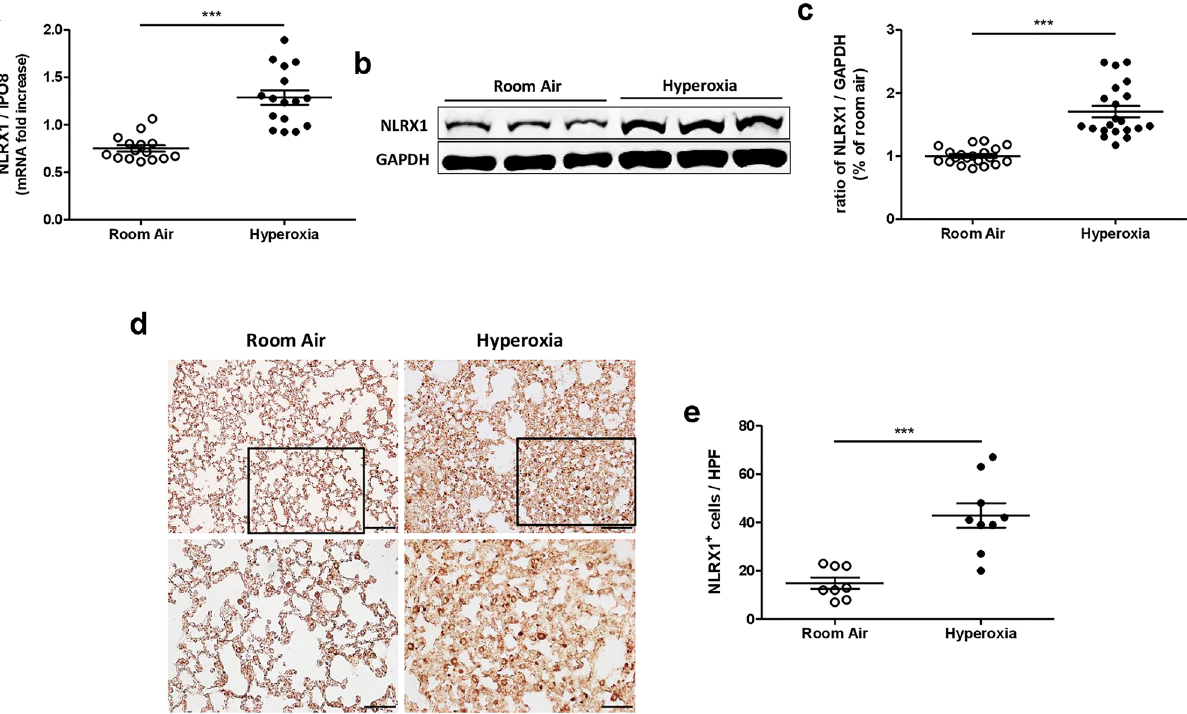
Figure 1. NLRX1 expression levels are increased in a murine model of hyperoxia. Wild-type mice were exposed to room air (n = 5) or hyperoxia (≥ 95% oxygen) (n = 5) respectively for 72 h. After 72 h, mice were sacrificed and collected lung tissues were analyzed. ( A ) mRNA levels for NLRX1 in lung lysates were measured by real-time PCR. ( B ) NLRX1 protein expression was evaluated via western blot using lung lysates, and ( C ) the signal intensity of NLRX1 was quantified. ( D ) Immunohistochemical staining of NLRX1 was assessed in mouse lung tissue, and ( E ) NLRX1 positive cells were counted. Scale bars 100 µm and 50 µm. Results are presented as the mean ± SEM and are representative of at least three independent experiments. The images of the original blots are available in Supplementary Information. Some blots were cut prior to hybridization with antibodies. *** p < 0.001 (Student’s t test). HPF high power